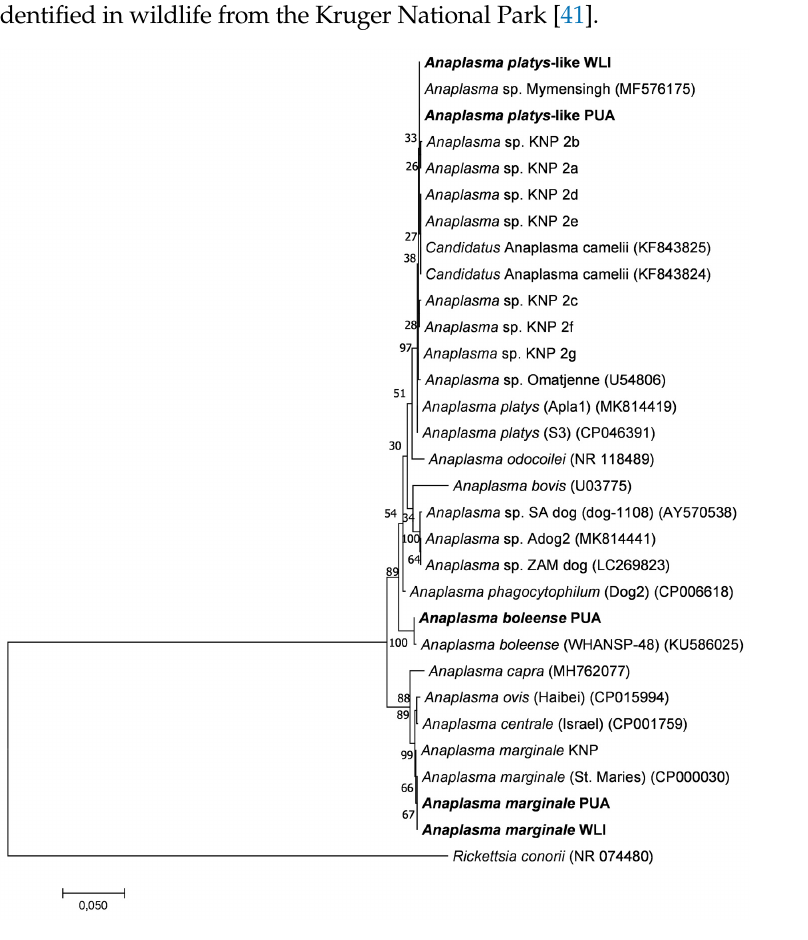
Figure 5. Maximum likelihood phylogenetic tree showing the phylogenetic relationships between Anaplasma 16S rRNA gene sequences obtained from the ten calves included in this study (in bold) and previously published Anaplasma 16S rRNA gene sequences. Near full-length 16S rRNA gene sequences of approximately 1328 bp in length were used to construct the tree. The numbers associ- ated with each node indicate the percentage of 1000 bootstrap replications supporting the node. Phylogenetic analyses were conducted in MEGA7 with an HKY85 evolutionary model. Sequences with abbreviations PUA, WLI, and KNP highlight that the sequences were retrieved from animals in the peri-urban area, wildlife–livestock interface and Kruger National Park, respectively. Rickettsia conorii was used as the outgroup. The scale bar highlights a 5% nucleotide sequence divergence.